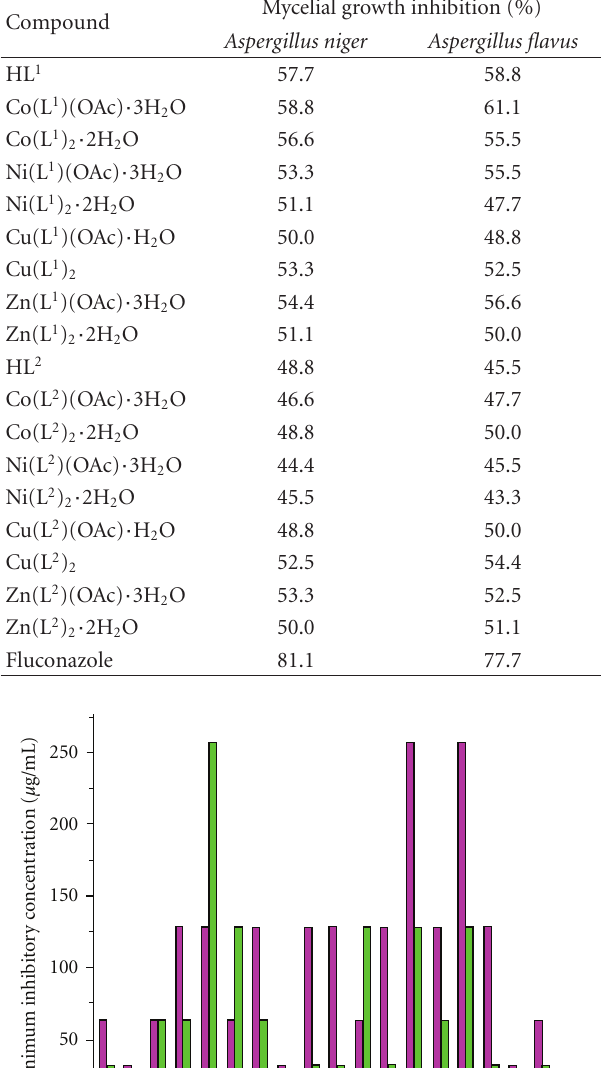
Table 5: Antibacterial activity of synthesized compounds.